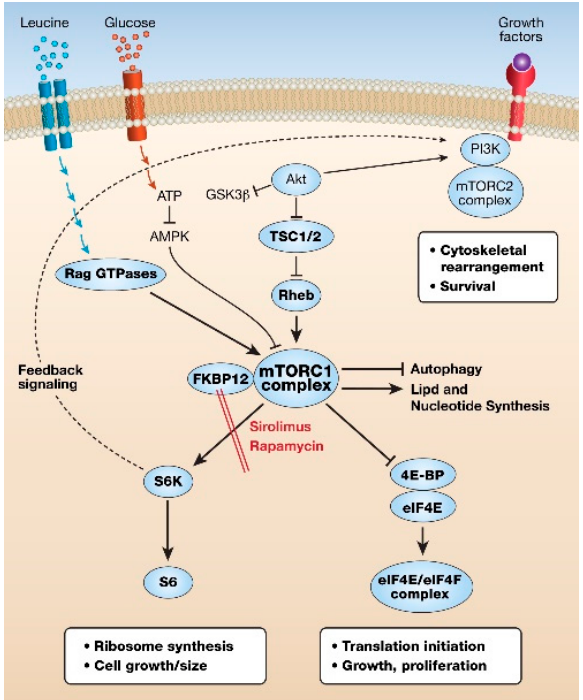
Figure 1. Cartoon of major proteins in the mechanistic target of rapamycin (mTOR) growth pathway. Extracellular high-energy conditions decrease the suppressor activity of the tuberous sclerosis complex (TSC)1/TSC2 and amino acids activate RAG GTPases and Ras homolog enriched in the brain (Rheb) GTP-binding protein, stimulating mTORC1 kinase. mTORC1 phosphorylation activates S6 kinase (S6K) and S6 ribosome synthesis. Phosphorylation of eukaryotic initiation factor 4E (eIF4E)-binding protein (4E-BP) releases the rate-limiting initiation factor eIF4E, resulting in enhancement of the translation of complex capped mRNAs. Overall, increased mRNA translation, increased lipid and nucleotide synthesis, and inhibition of autophagy result in cellular growth and proliferation.